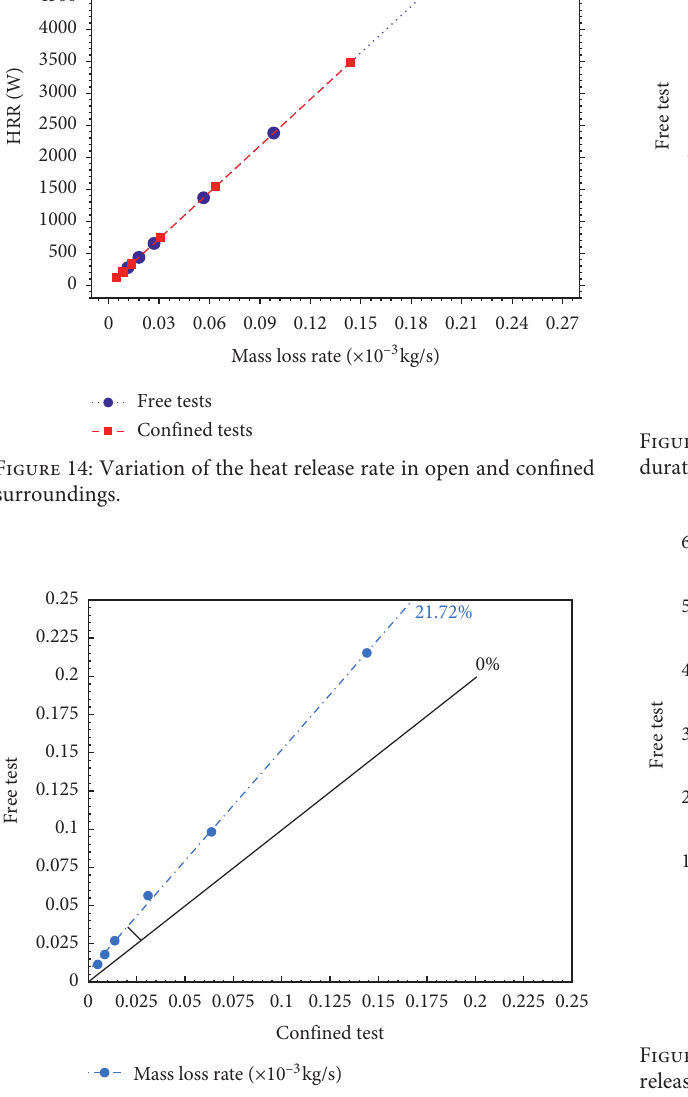
Figure 15: Angle of the shift of the effect of confining on the mass loss rate of fuel.